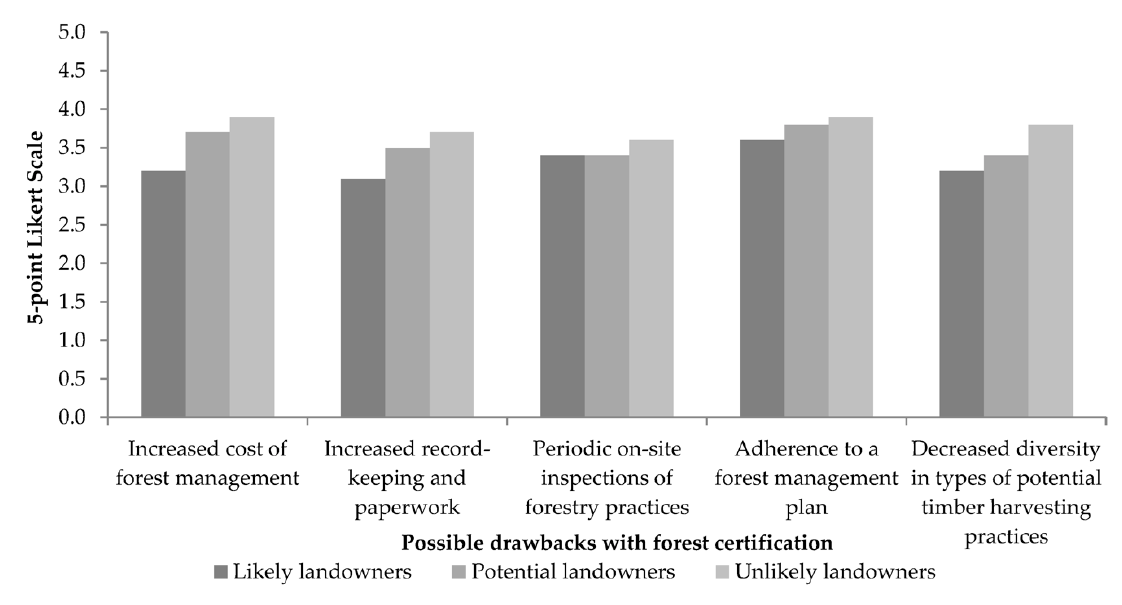
Figure 3. Landowners’ perception of potential drawbacks of forest certification.